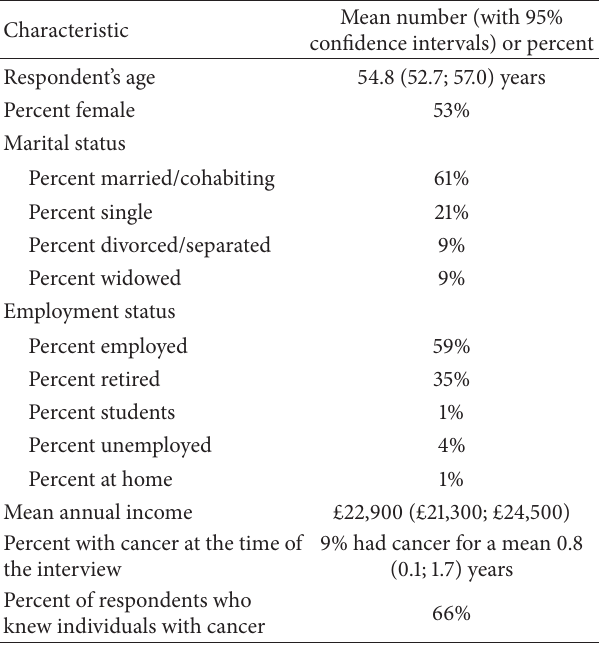
Table 2: Respondents’ socio-demographic